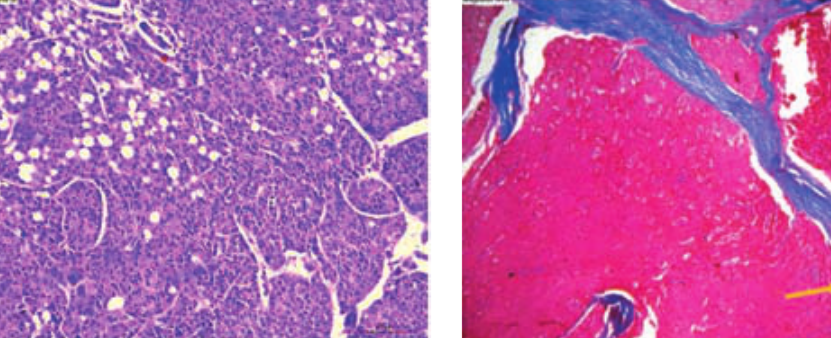
Fig. 1. Hepatoid gland adenoma- Proliferation of hepatocyte like hepatoid cells with extensive sebaceous differentiation (H &E x 100)